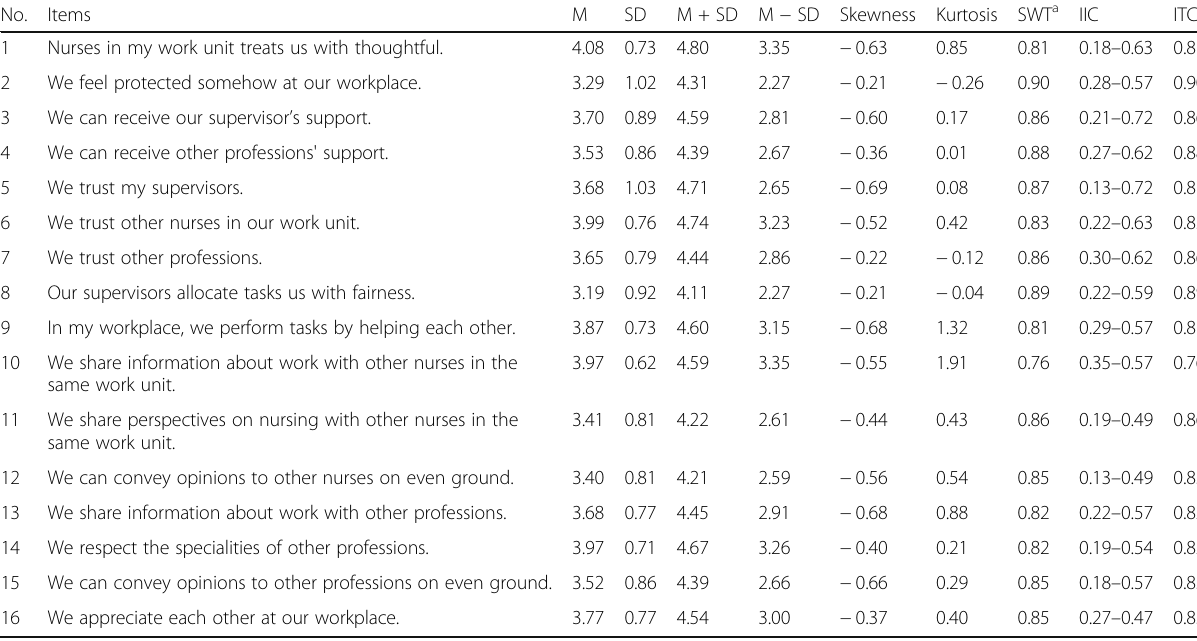
Table 2 Descriptive statistics and item analysis for items on the RWSCS-JN No.